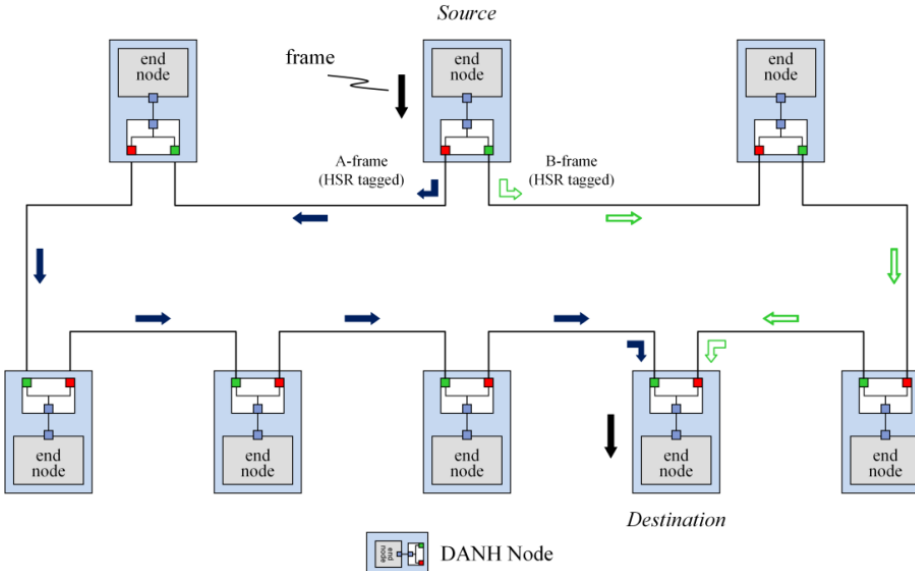
Figure 2. HSR example of single-ring topology for unicast traffic.